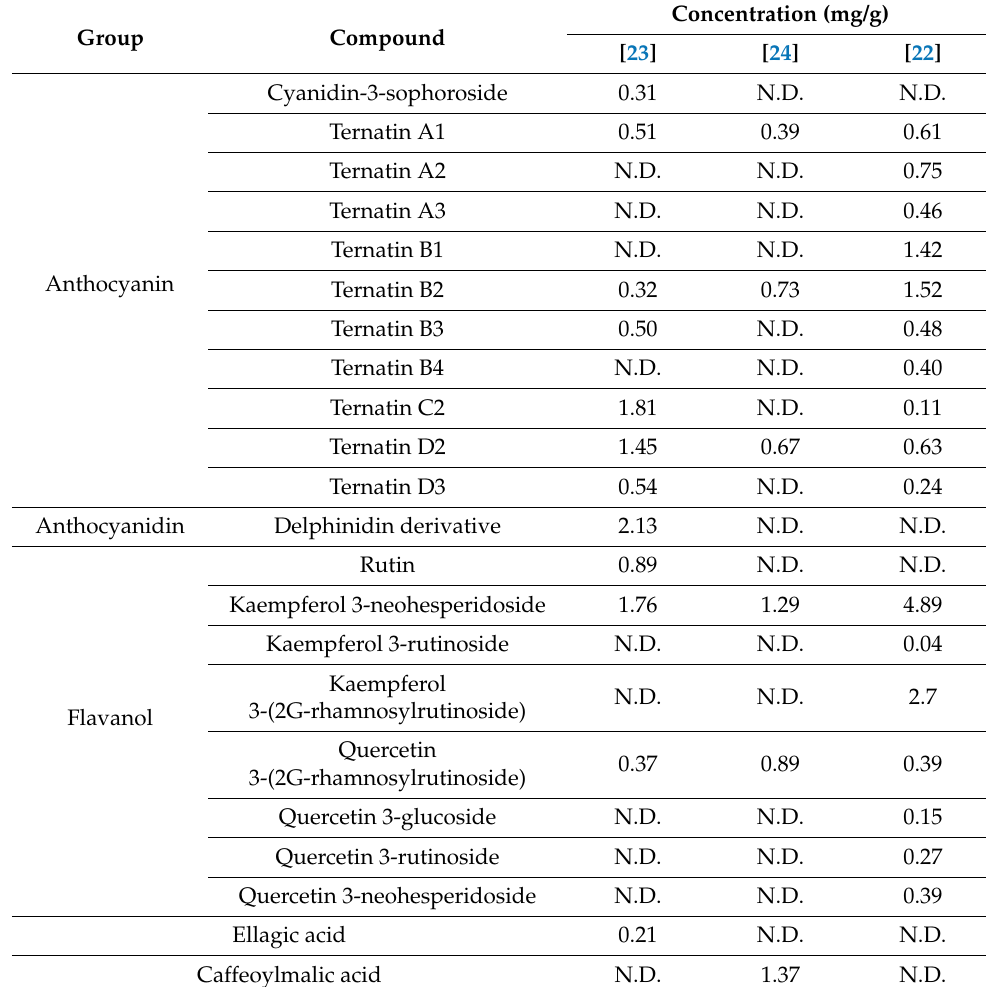
Table 1. Hydrophilic compounds composition of C. ternatea flower.